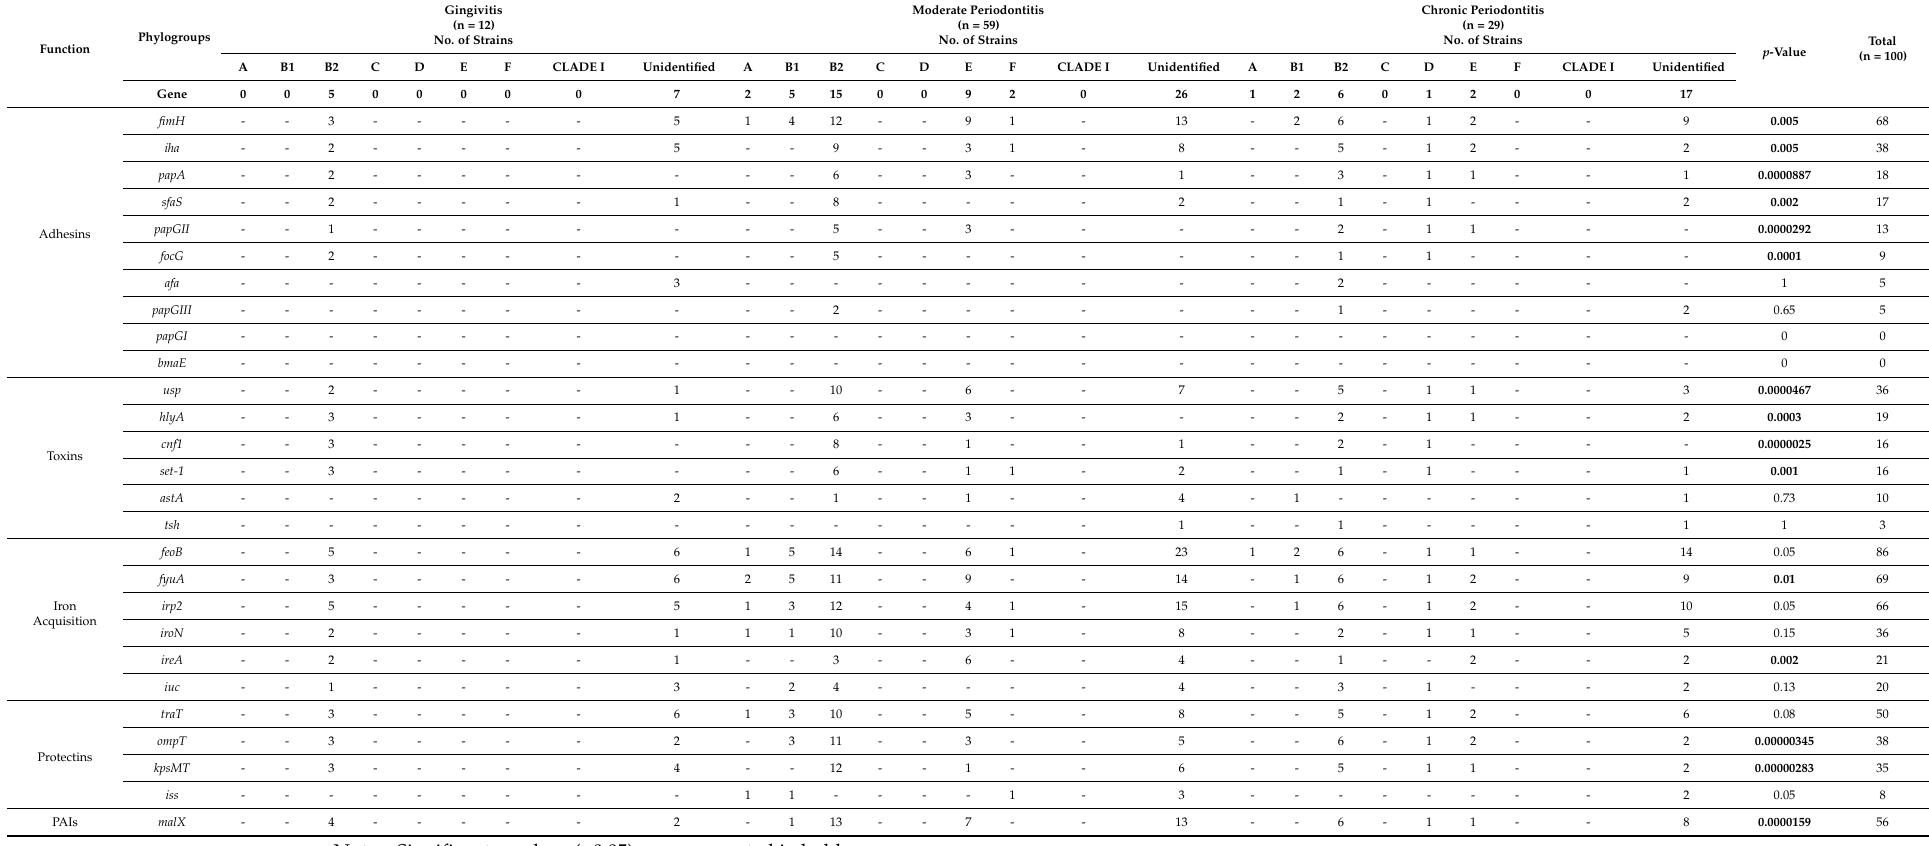
Table 2. Frequency of virulence genes according to phylogroups in E. coli .